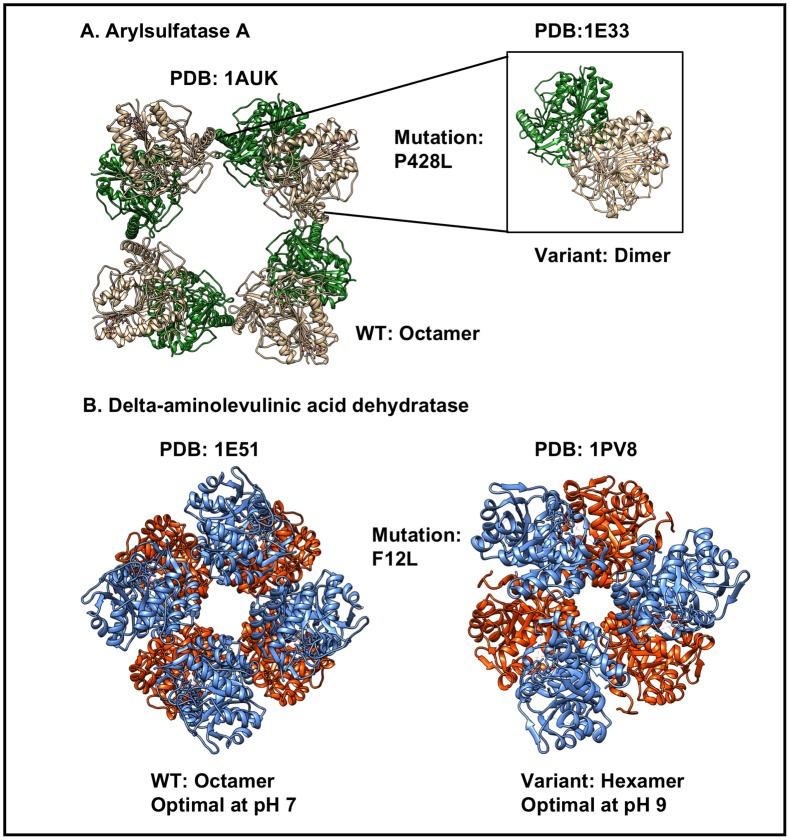
SNVs that affect both protein structure and function.A) The P428L mutant form of Arylsulfatase A adopts an atypical dimeric configuration (instead of the normal octamer), which reduces protein half-life. B) The F12L mutant form of Delta-aminolevulinic acid dehydratase assembles as a hexamer (instead of the normal octamer), which shifts the pH optimum of the enzyme from pH 7→pH 9.